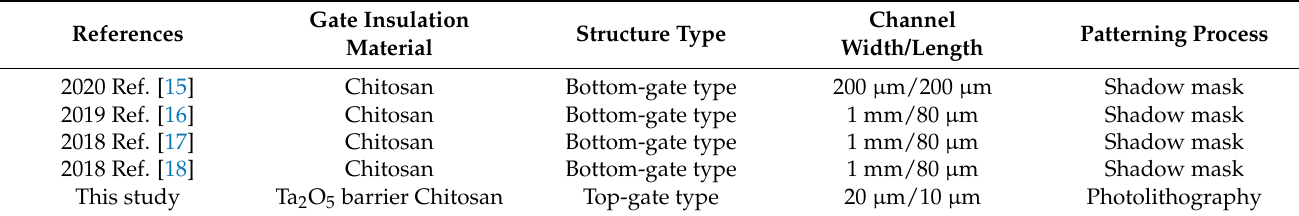
Table 1. Benchmark of synaptic transistors using chitosan electrolyte as an electric double layer.